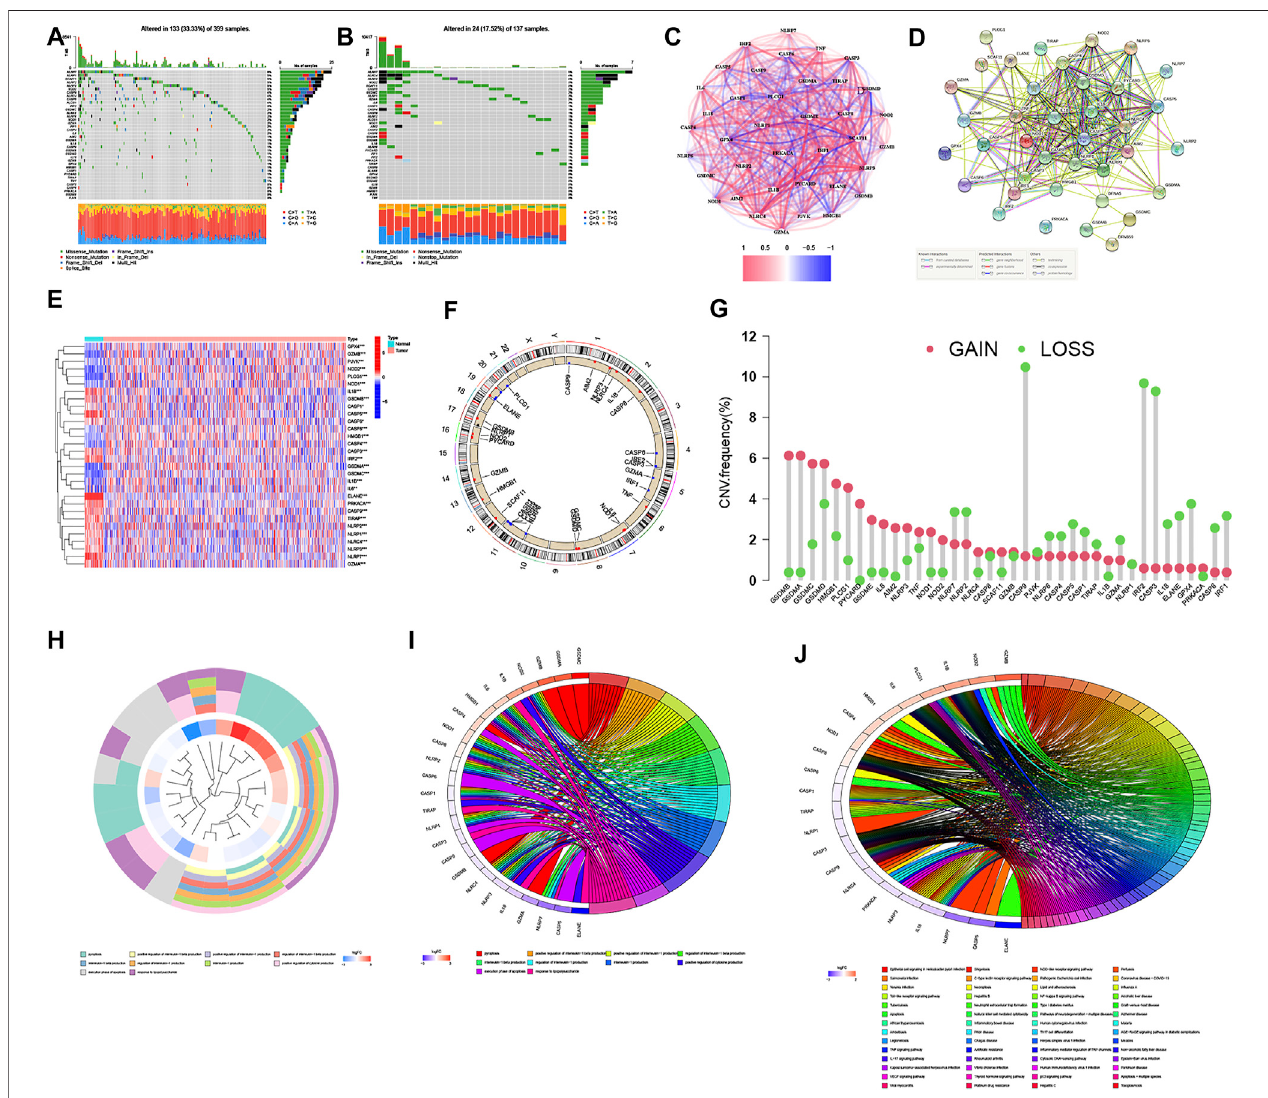
FIGURE1| Landscapeofthegeneticalterations,expressions,andfunctionsofPRGsinCRC. (A,B) Mutationfrequenciesof38PRGsin399and137patientswith COAD and READ based on the TCGA cohort, respectively. (C) Correlation network of PRGs (the depth of the colors re fl ects the strength of the relevance, red line: positive correlation; blue line: negative correlation). (D) PPI network showing the interactions of PRGs (the minimum required interaction score was 0.4). (E) Heatmap of thePRGsbetweenthenormalandthetumortissues(blue:lowexpressionlevel;red:highexpression level).* p < 0.05;** p < 0.01;and*** p < 0.001. (F,G) Locations of CNV alterations in PRGs on 23 chromosomes and the frequencies of CNV gain, loss, and non-CNV among PRGs, respectively. (H – J) Functional enrichment analysis of the differential expression levels of 30 PRGs ((H): heatmap clustering functional analysis; (I) enriched item in gene ontology analysis; (J) enriched item in Kyoto Encyclopedia of Genes and Genomes